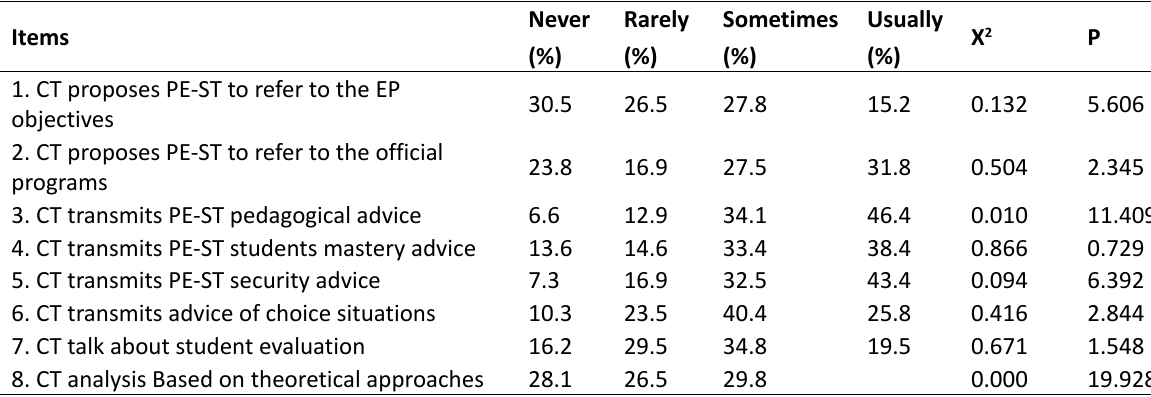
Table 2. The different items of the CT practical